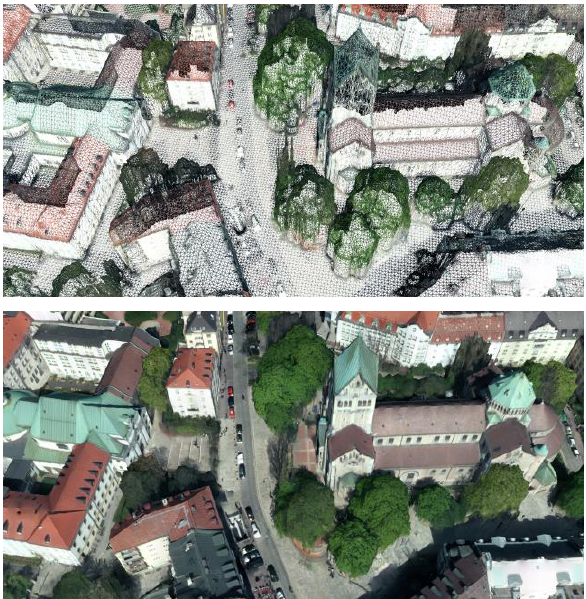
Figure 2. Texture mapped triangulated DSM raster showing vertices (top) and faces